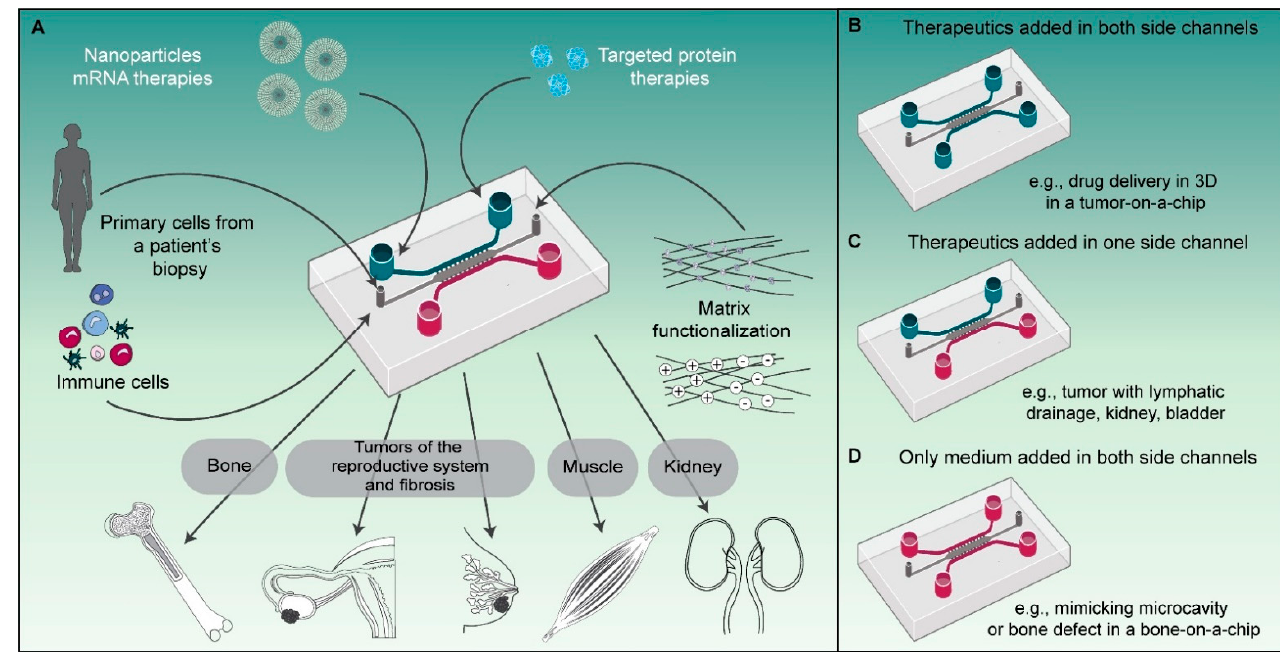
Figure 4. Schematic representation of the versatility of our microfluidic platform to study protein therapies and nanomedicines in various organ-on-a-chip systems. ( A ) Schematic with different parameters that can be included or modified in the microfluidic platform to mimic organ physiology and drug delivery. ( B ) Schematic of a microfluidic chip with drug delivery from both side channels as in the tumor-on-a-chip implementation utilized in this study to deliver anti-CAIX affibodies to tumor cells. ( C ) Alternative use of the microfluidic platform for mimicking the physiology of compartmentalized organ substructures from the kidney or bladder or the lymphatic drainage present in some tumors. ( D ) Schematic of the microfluidic chip with addition of only medium in the side channels, as studied in this paper, to mimic a bone-on-a-chip.